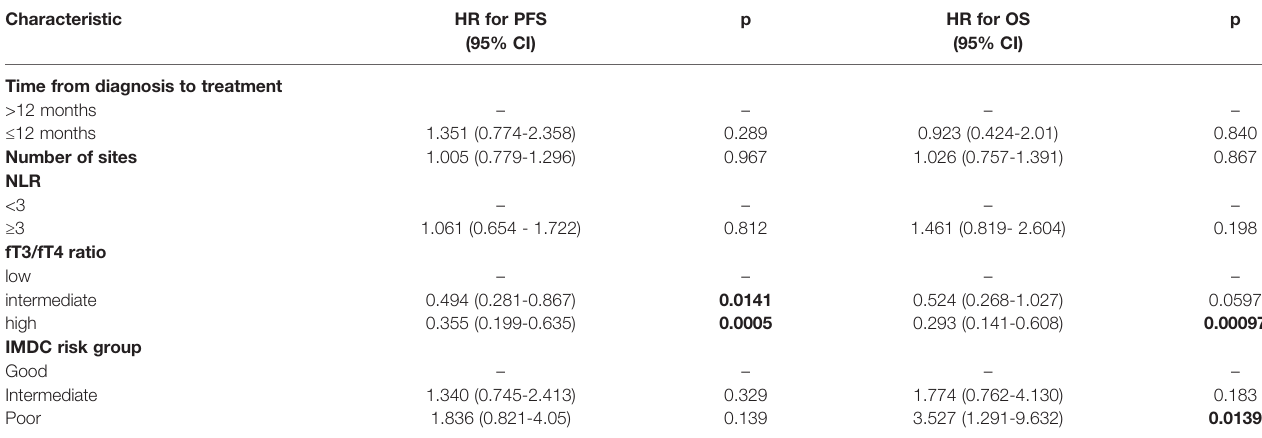
TABLE 3 | Multivariate analysis for PFS and